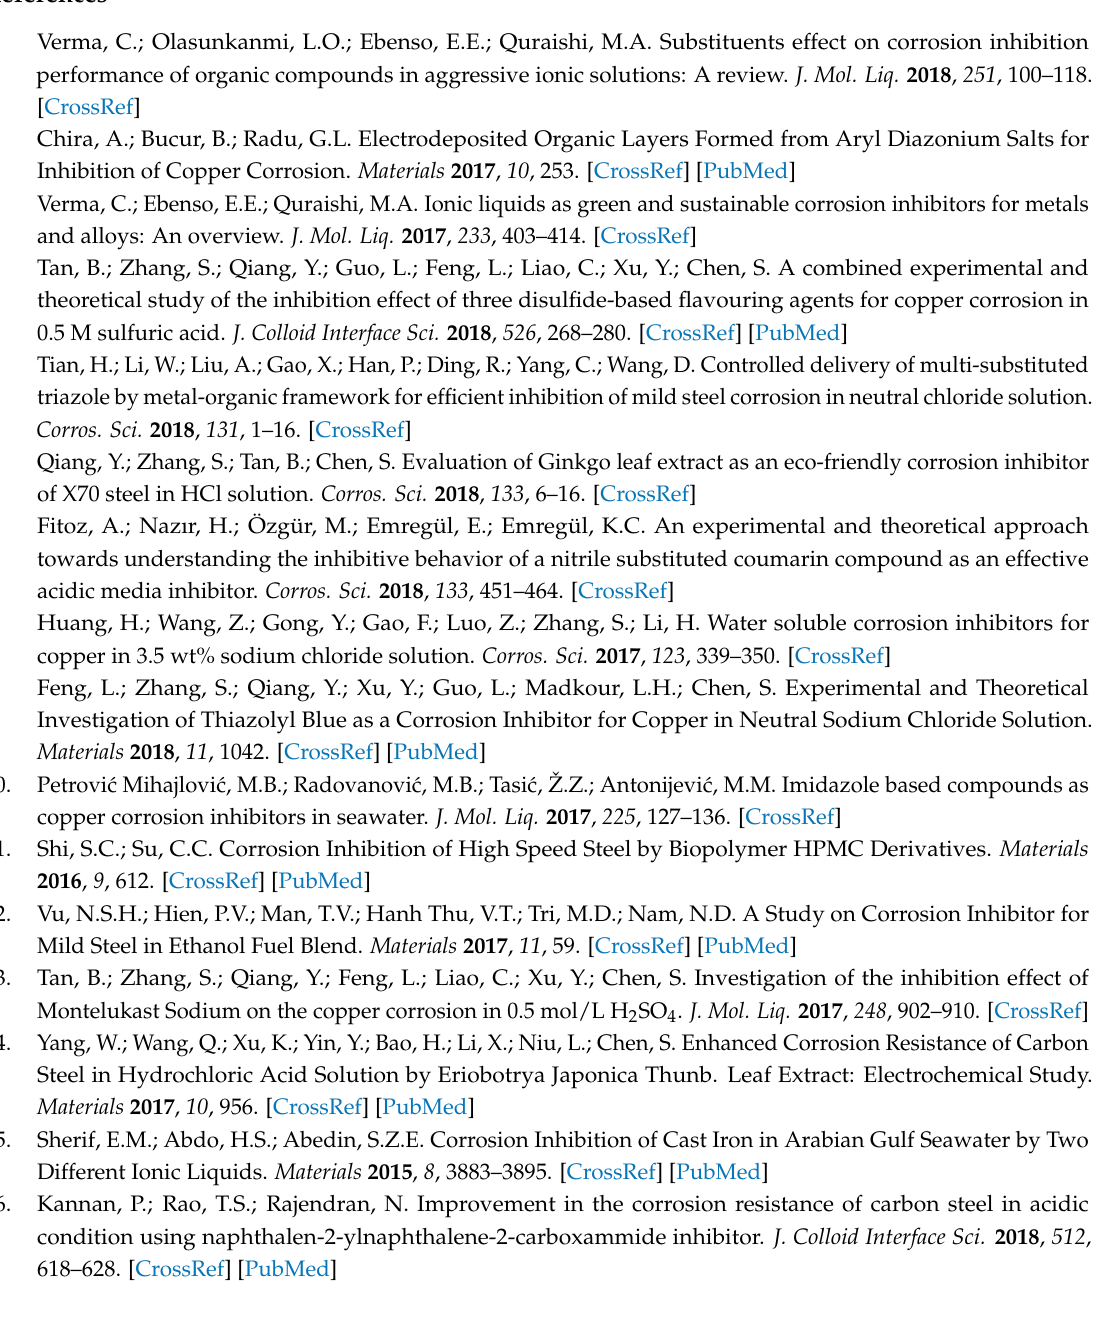
s1, Figure S1: The Flory-Huggins adsorption isotherm plots of copper with different concentrations of itraconazole in 0.5 mol/L H 2 SO 4 at diverse temperatures, Figure S2: The Temkin adsorption isotherm plots of copper with different concentrations of itraconazole in 0.5 mol/L H 2 SO 4 at diverse temperatures, Figure S3: The El-Awady adsorption isotherm plots of copper with different concentrations of itraconazole in 0.5 mol/L H 2 SO 4 at diverse temperatures, Figure S4: The Frumkin adsorption isotherm plots of copper with different concentrations of itraconazole in 0.5 mol/L H 2 SO 4 at diverse